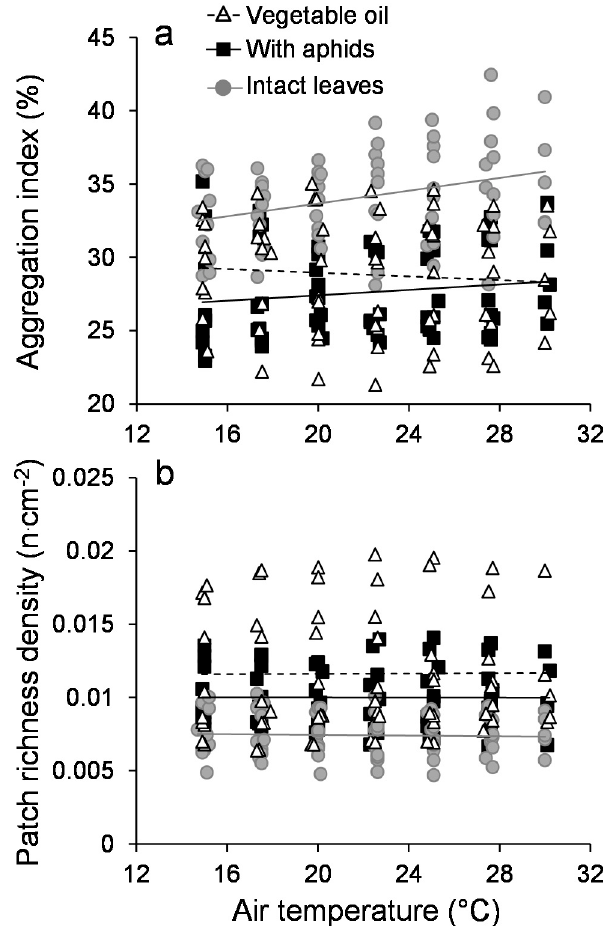
Figure 3. Configuration of the leaf surface thermal heterogeneity. Dynamics of ( a ) the aggregation index (AI) and ( b ) the patch richness density (PRD) as function of air temperature for intact leaves (grey circles), leaves covered with vegetable oil (white triangles) and leaves infested with green apple aphids (black squares). The AI defines the way groups of pixels with similar temperatures are arranged spatially: it is zero when similar pixels are spread across the surface, and it equals 100 when the aggregation is maximal. The PRD is the count of different temperature values (with a 0.1 °C resolution) relative to the total number of pixels in the thermographic image: it is close to zero when the diversity of temperature values is small, and it increases when every single pixel has a unique temperature value.